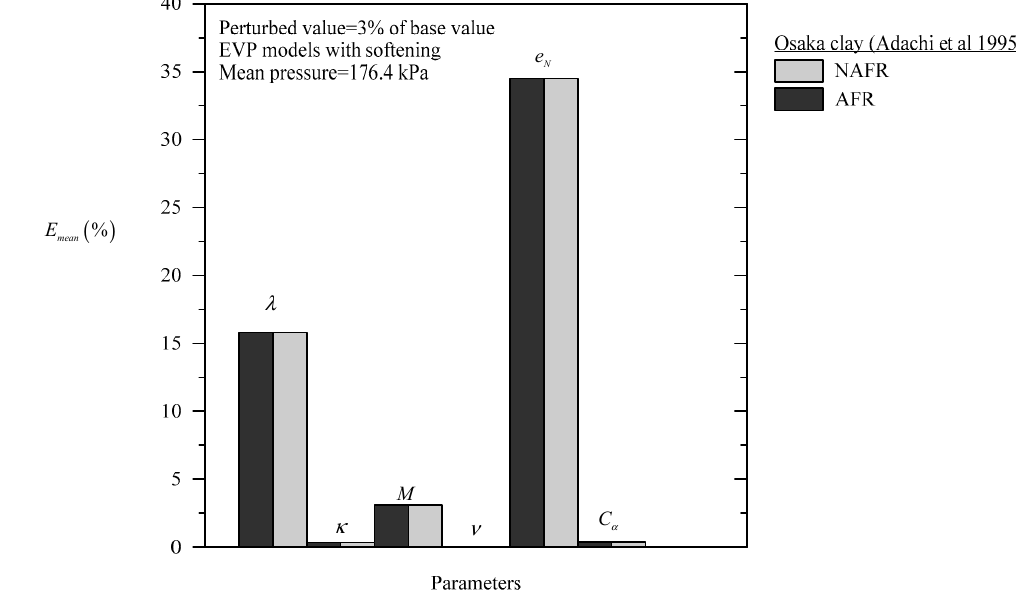
Figure 9. Sensitivity of perturbation for Osaka clay.